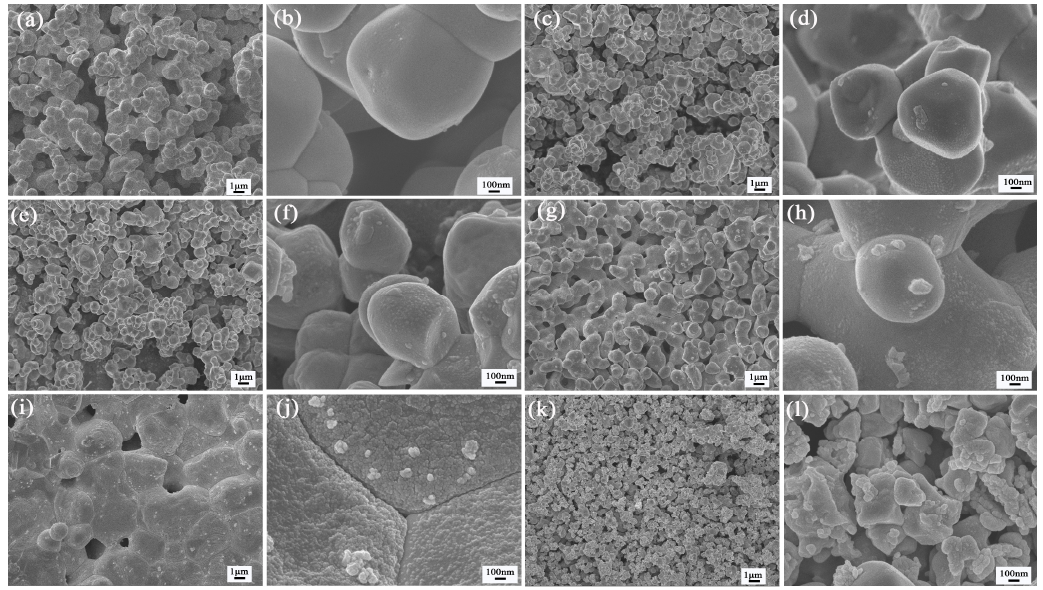
Figure 4. SEM images of: pristine Ag 3 PO 4 ( a , b ); Ag 3 PO 4 -100 ( c , d ); Ag 3 PO 4 -200 ( e , f ); Ag 3 PO 4 -300 ( g , h ); Ag 3 PO 4 -400 ( i , j ); and the reused Ag 3 PO 4 -200 sample ( k , l